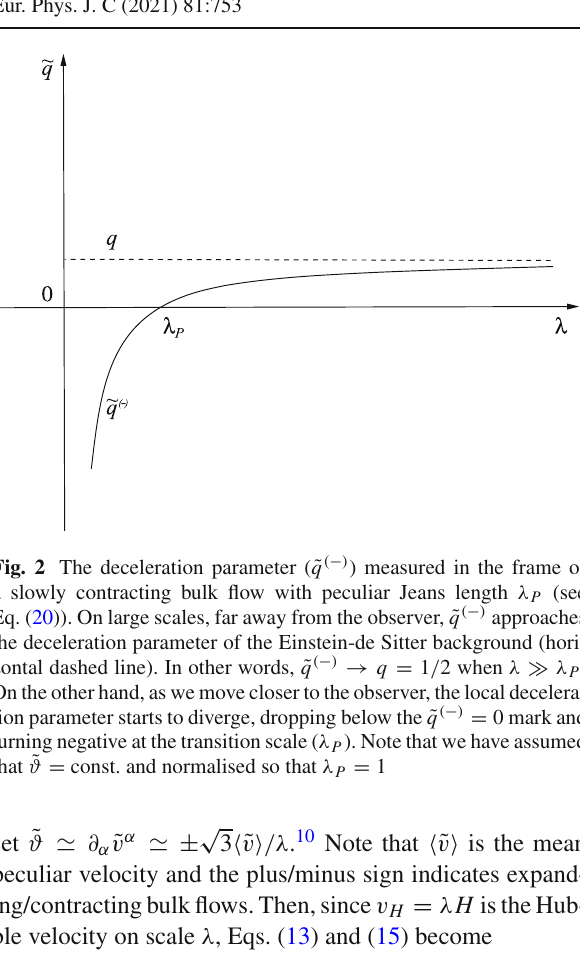
(cid:10)˜ v (cid:11) ) is